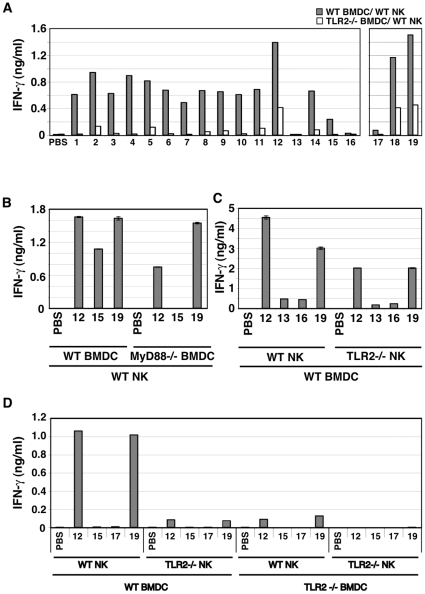
TLR2 on BMDC mainly participate in Pam2Cys-mediated NK activation.(A) BMDC TLR2-independent NK activation by Pam2Cys12, 18 and 19. BMDC from wild-type (closed bars) or TLR2−/− (open bars) mice were stimulated with control PBS or 100 nM of indicated Pam2Cys peptides for 4 h. Cells were then co-cultured with wild-type NK cells at 1∶2 ratio for 24 h. Then, the supernatants were collected and IFN-γ was measured by ELISA. (B) Pam2Cys12 and 19 induce NK activation in culture with MyD88−/− BMDC. NK cells were co-cultured with wild-type or MyD88−/− BMDC in the presence of the indicated Pam2Cys peptides (represented by the numbers) as in Fig. 2. 24 h after incubation, culture media were collected to determine cytokines by ELISA. (C) Pam2Cys12 and 19 induce TLR2−/− NK activation in culture with wild-type BMDC. Wild-type BMDC and NK cells with either wild-type or TLR2−/− phenotype were incubated at 1∶2 ratio with the indicated Pam2Cys peptides (represented by the numbers) as in Fig. 2. 24 h after incubation, culture media were collected to determine cytokines by ELISA. One representative of the three similar experiments is shown. (D) TLR2 NK cells mainly participates in TLR2 BMDC-independent NK activation by Pam2Cys12 and 19. Wild-type and TLR2−/− BMDC were stimulated with indicated Pam2Cys peptides for 4 h. These BMDC were then mixed with NK cells as shown in the panel. Four groups consisting of either of wild-type NK or TLR2−/− NK and either of wild-type BMDC or TLR2−/− BMDC (see the bottom of the panel) were incubated with the indicated Pam2Cys peptides (50 nM) for 24 h. NK cells alone with Pam2Cys12 or 19 liberated minure IFN-γ as in the panel with WT NK + TLR2−/− BMDC (see Fig. S1). IFN-γ concentrations in the culture supernatants were determined by ELISA. The data shown are representative of at least three independent experiments.